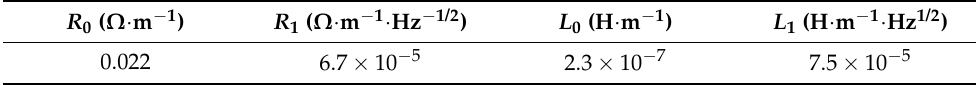
Table 1. Estimates of the parameters of 𝑅(𝜔) and 𝐿(𝜔) models.